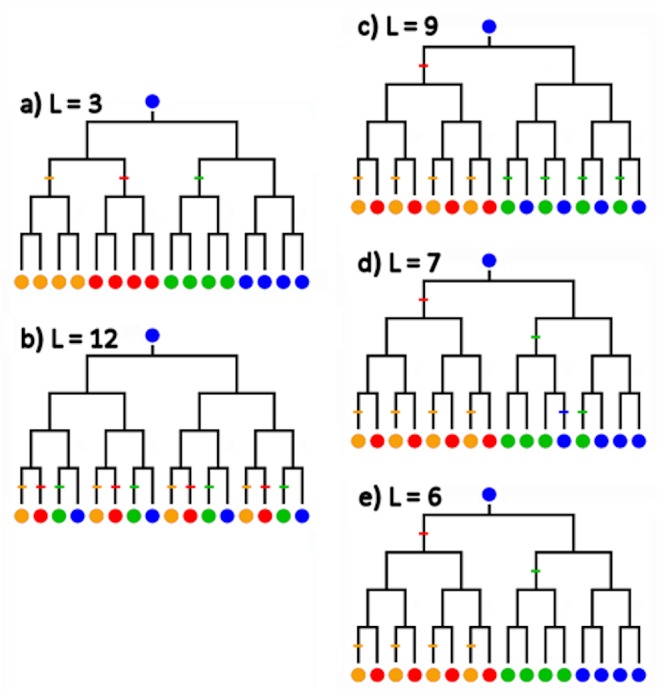
Dispersal tree length decreases as phylogeography becomes more structured.Consider a dichotomously-branching mitogenomic tree of 16 individuals distributed among four geographic areas (red, orange, green, and blue), with one population (blue) designated as ancestral. (A) The most highly structured model, in which each of the three alternative areas corresponds to a separate clade originating by a single dispersal event, requires just L = 3 events. (B) The least structured model, in which clades are distributed uniformly among areas such that there is no correspondence between genetic relationship and population, requires L = 12 events. [Model drawn with delayed events, and terminal red / orange and green / blue pairs: alternative event distributions are possible]. Intermediate structures include: (C) Separate clades in the red and orange areas and in the green and blue areas, but uniform geographic distribution within those two clades (L = 9), (D) as in (C) but with minimal exchange between blue and green areas (L = 7), and (E) as in (C) but with complete separation of blue and green (L = 6). The models are drawn with delayed dispersal events: other event distributions are possible. Models C, D, & E are analogous respectively to a two-population Harp Seal model, a three-population mixed model with a uniform single Northwest Atlantic population and limited exchange between the Greenland and White Seas, and a pure three-population model with separate Greenland and White Sea populations (cf. Fig 8).